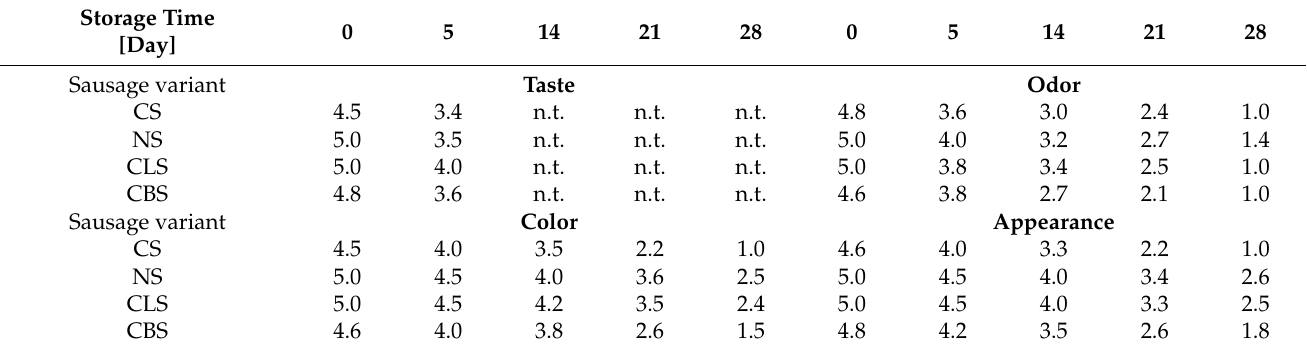
Table 8. Sensory analysis of the sausage variants during